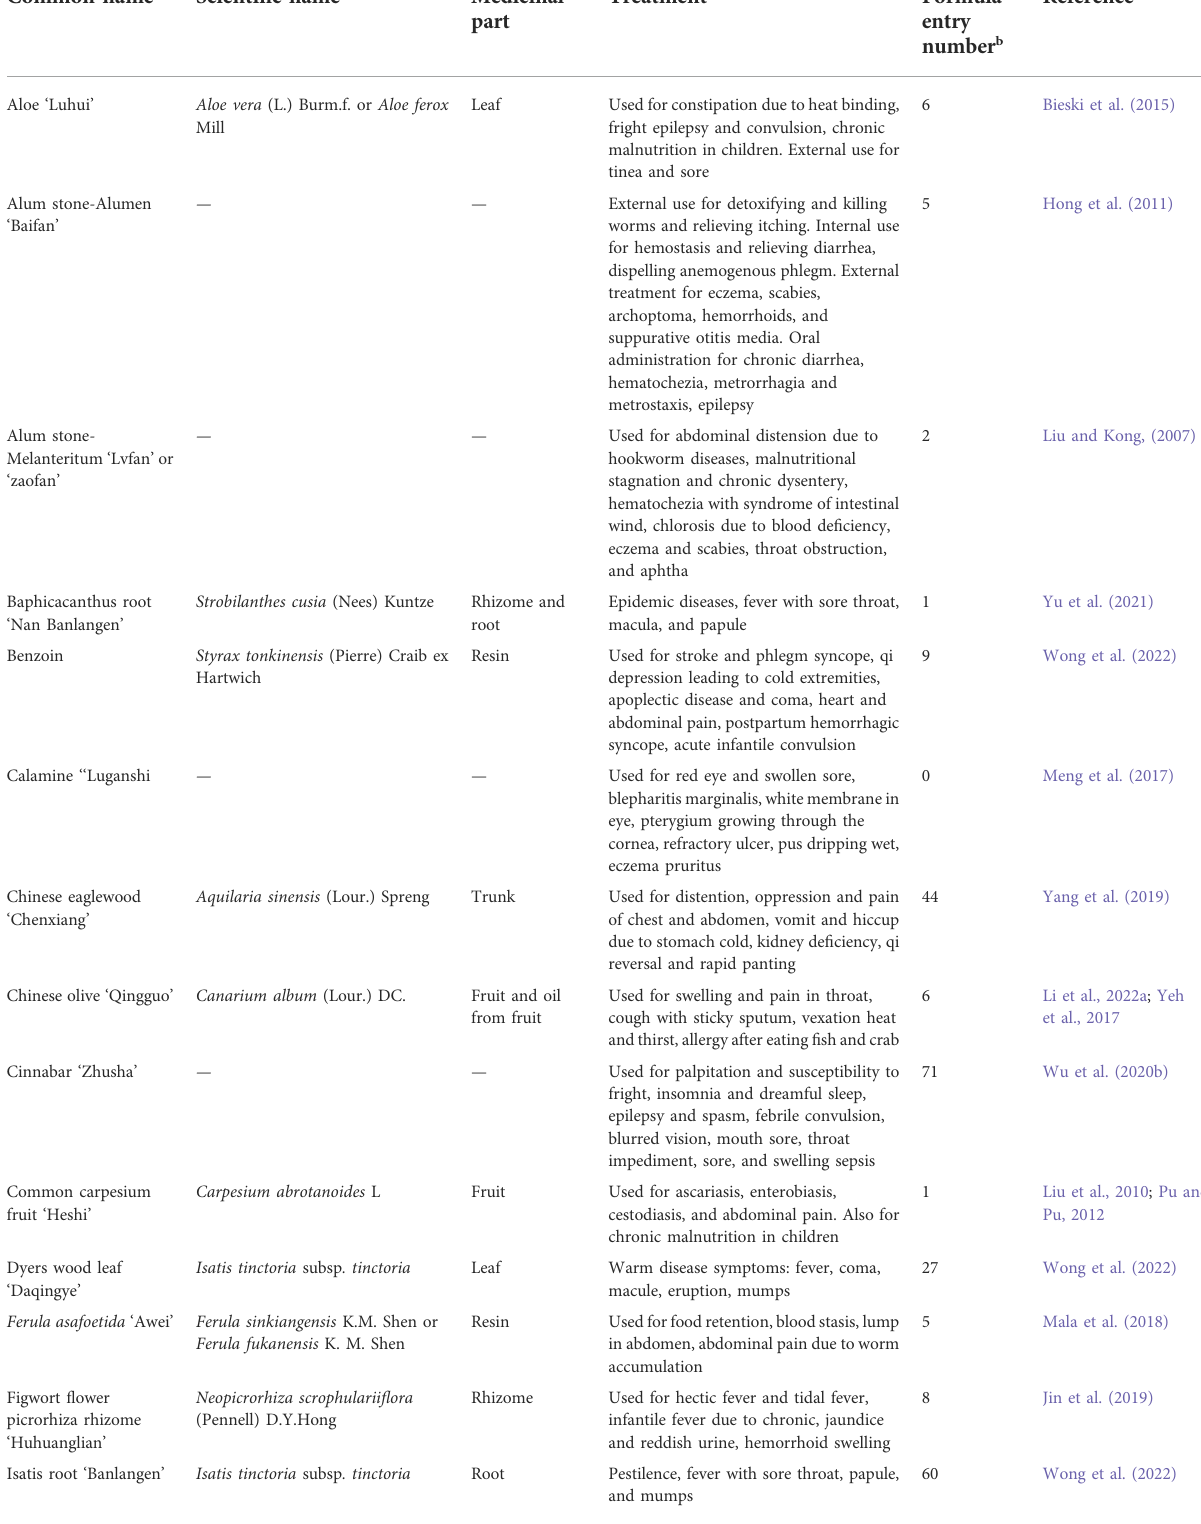
TABLE 3 Basic information in China Pharmacopoeia on medicinal materials recorded in the Compendium of Materia Medica.